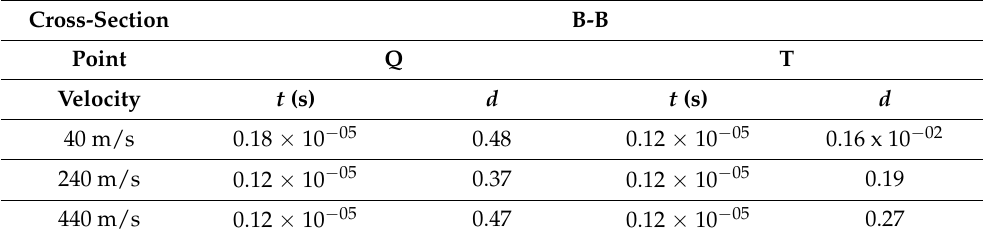
Table 2. Time instance (s) when damage appears at observed points and the damage value, cross- section B-B.